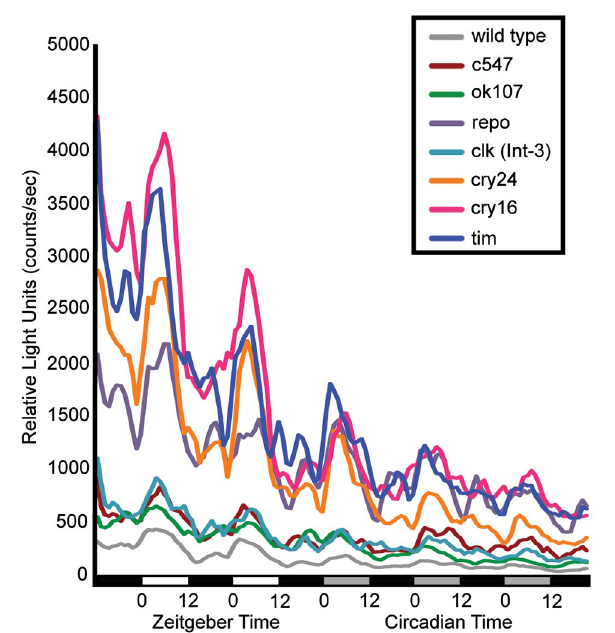
FIGURE 1 | dCREB2 transcriptional activity has a similar pattern of oscillation across cell populations. Bioluminescence is plotted in multiple fly lines expressing a dCREB2 luciferase reporter under the control of tissue-specific GAL4 drivers. Each line represents the mean reporter activity over time (hours) across flies ( n = 48) representing the progeny of UAS-FLP;CRE-F-luc transgenic flies crossed with wild type (gray), or GAL4 driver lines: c547 (red), ok107 (green), repo -GAL4 (purple), clk(int-3)-GAL4 (teal), crypGAL4-24 (cry24, orange) crypGAL4-16 (cry16, pink), tim -GAL4 (blue). Each data point represents the average over three hourly time points. Light conditions are indicated along the x-axis first in LD (black: night, white: day), then in DD (black: subjective night, gray: subjective day).